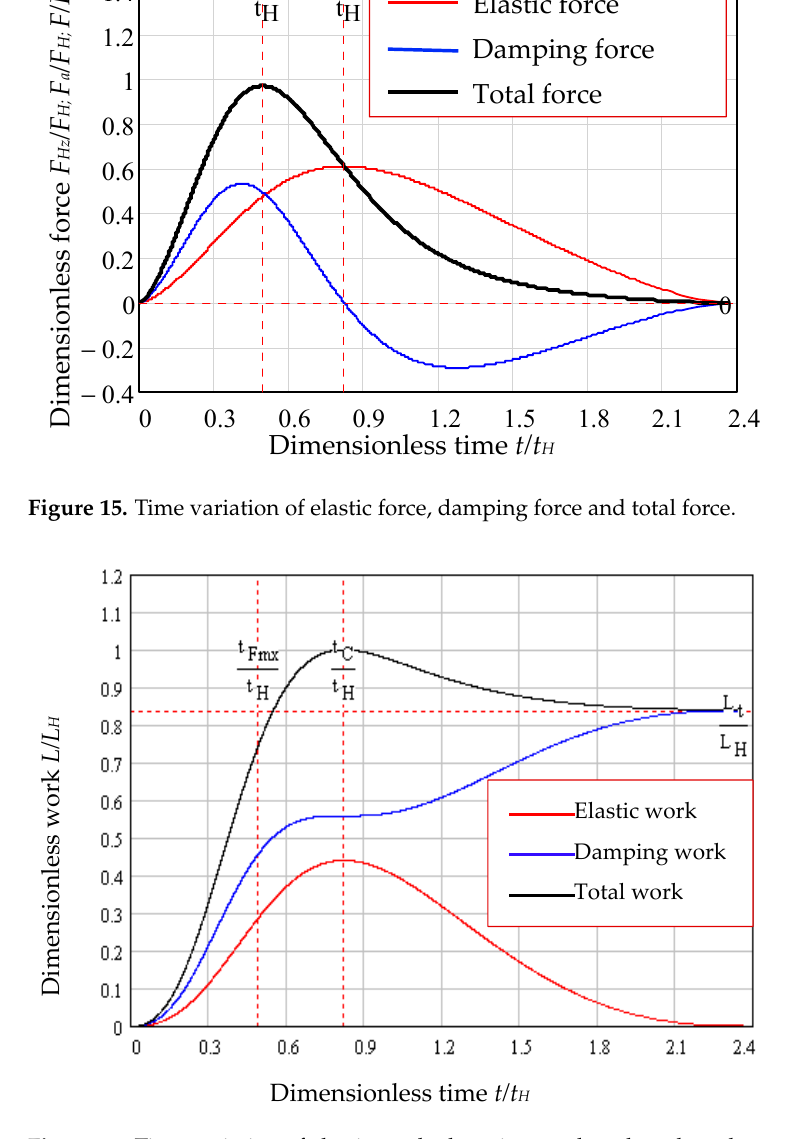
Figure 16. Time variation of elastic work, damping work and total work.